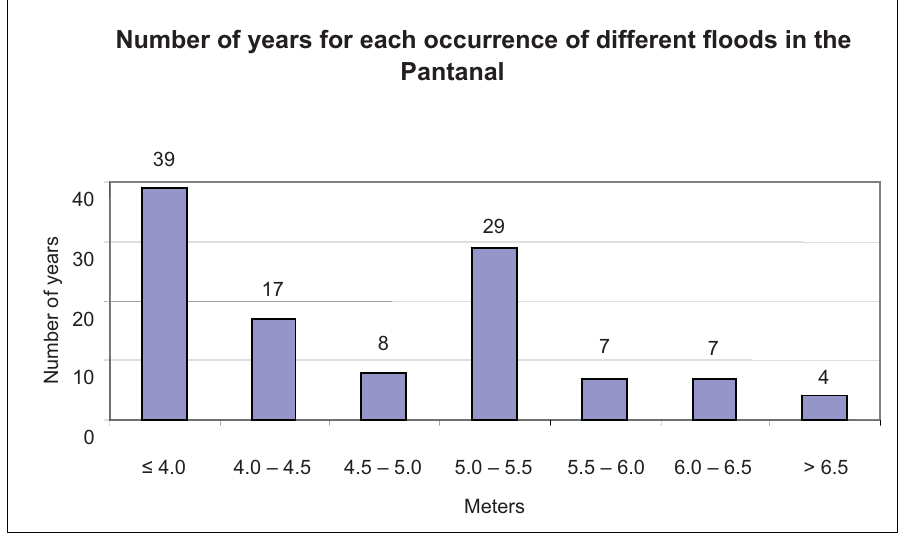
Figure 3. Number of years that floods occurred in the Pantanal, as recorded on the Paraguay River at Ladário Station.